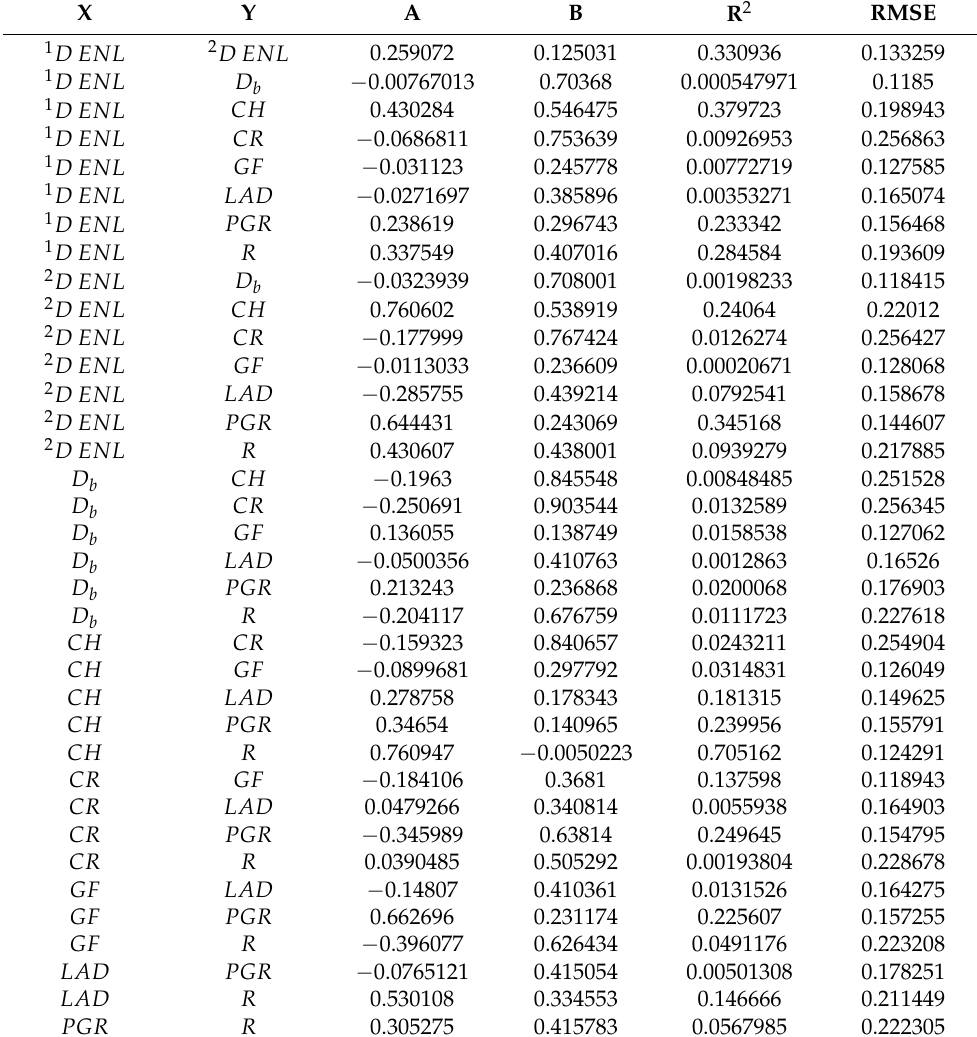
Table A4. Overview of TLS linear regression at 0.5 m grid size.